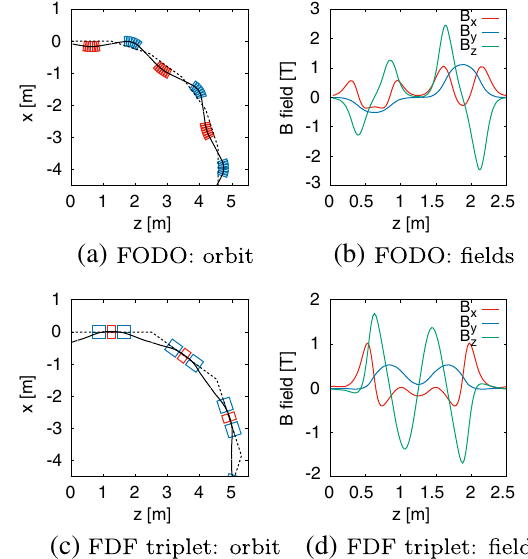
FIG. 2. Closed orbits for FODO (a) and FDF triplet lattices (c). The dashed line indicates the polygon with 20 sides for the FODO lattice and with 10 sides for the FDF triplet. Bd and Bf magnets are marked with by red and blue boxes respectively. In the FODO lattice, seven rectangular magnets mimic a sector magnet. Bd is shifted inward with respect to one side of polygon by x and Bf is shifted outward by x . The magnetic fields along s s the orbit in a cell for 12 MeV beam energy are shown for FODO (b) and FDF triplet